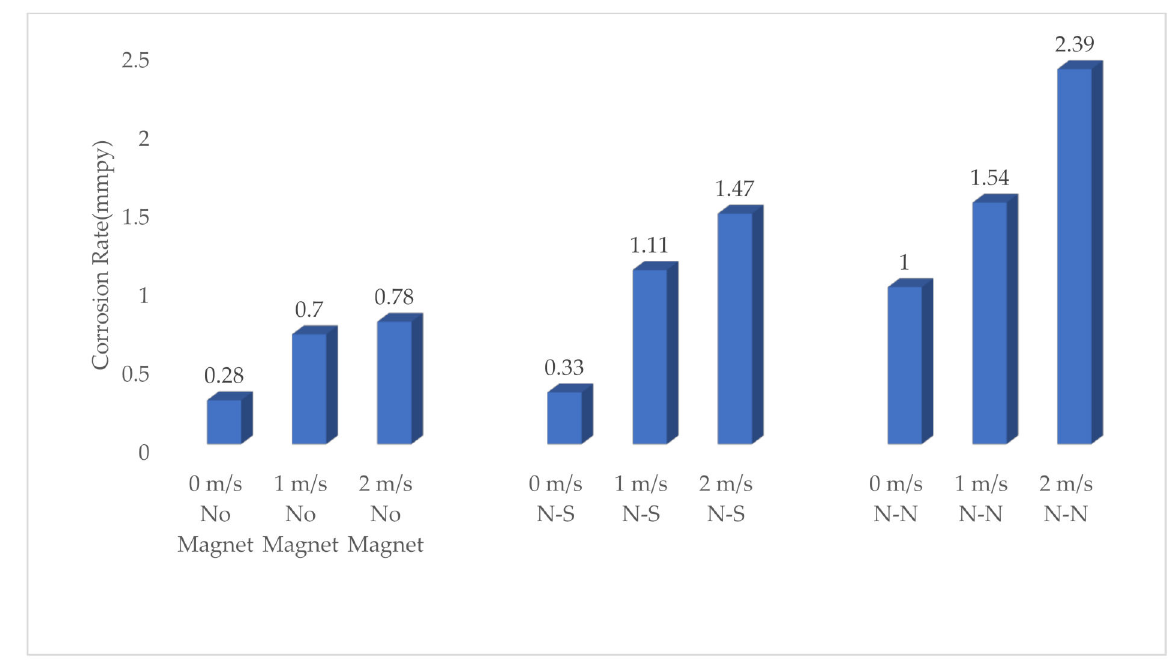
Figure 9. Corrosion rate of API 5L X65 samples at different flow